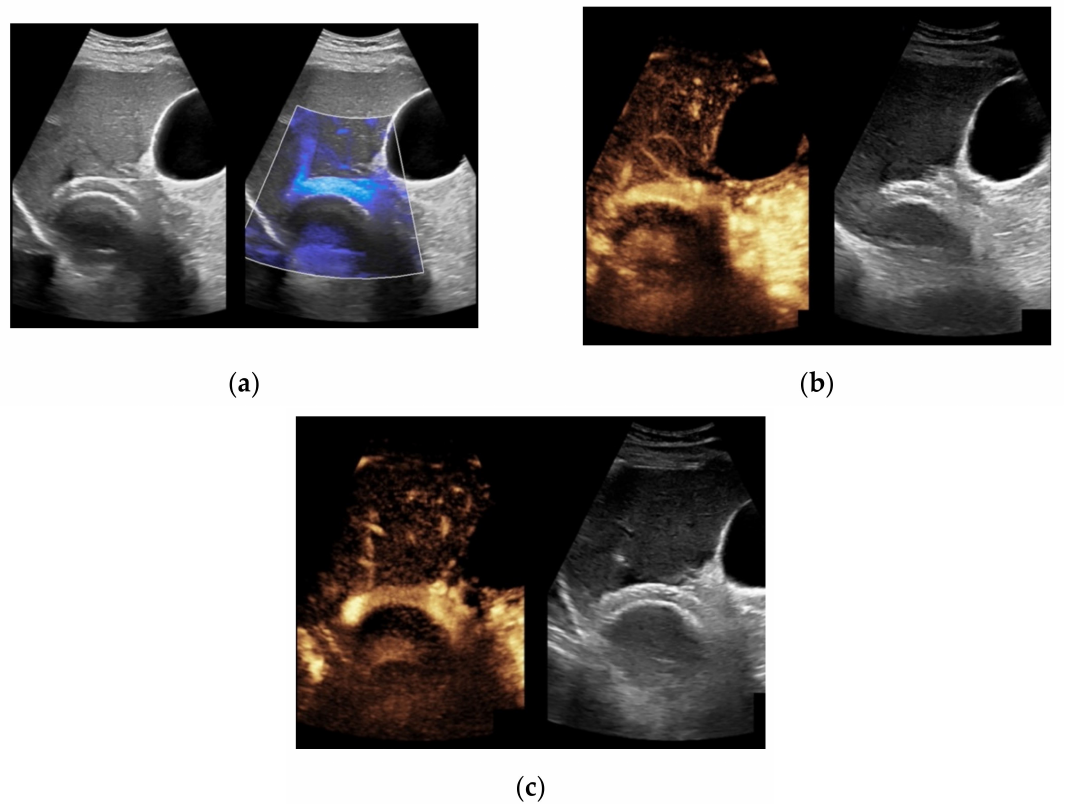
Figure 4. Same patient as in Figure 1 with continuous flow within the transjugular intrahepatic portosystemic shunt (TIPS) without thrombosis or occlusion using microflow imaging ( a ) and after administration of contrast agent ( b , c